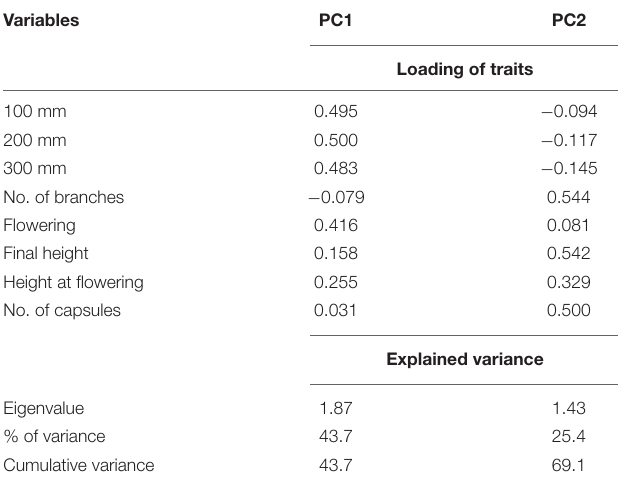
TABLE 4 | Principal component analysis of naturalized and casual populations of A. theophrasti